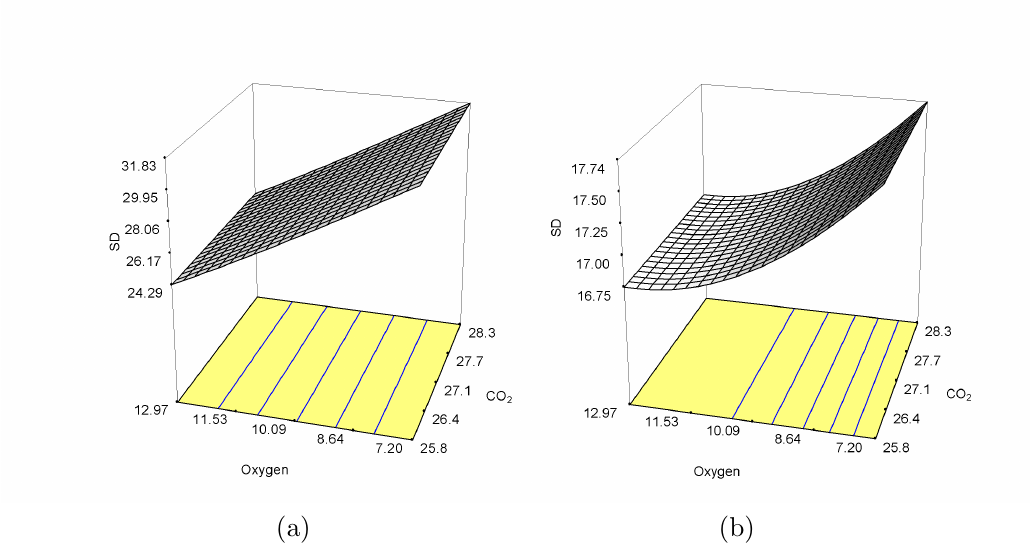
Figure 2: Effect of oxygen load (km 3 n/h) and CO 2 in RG concentration (vol %) on the SD of pure gas yield production (m 3 n/t DAF) at average stone content (5 mass %): (a) Typical broad PSD, (b) Finer